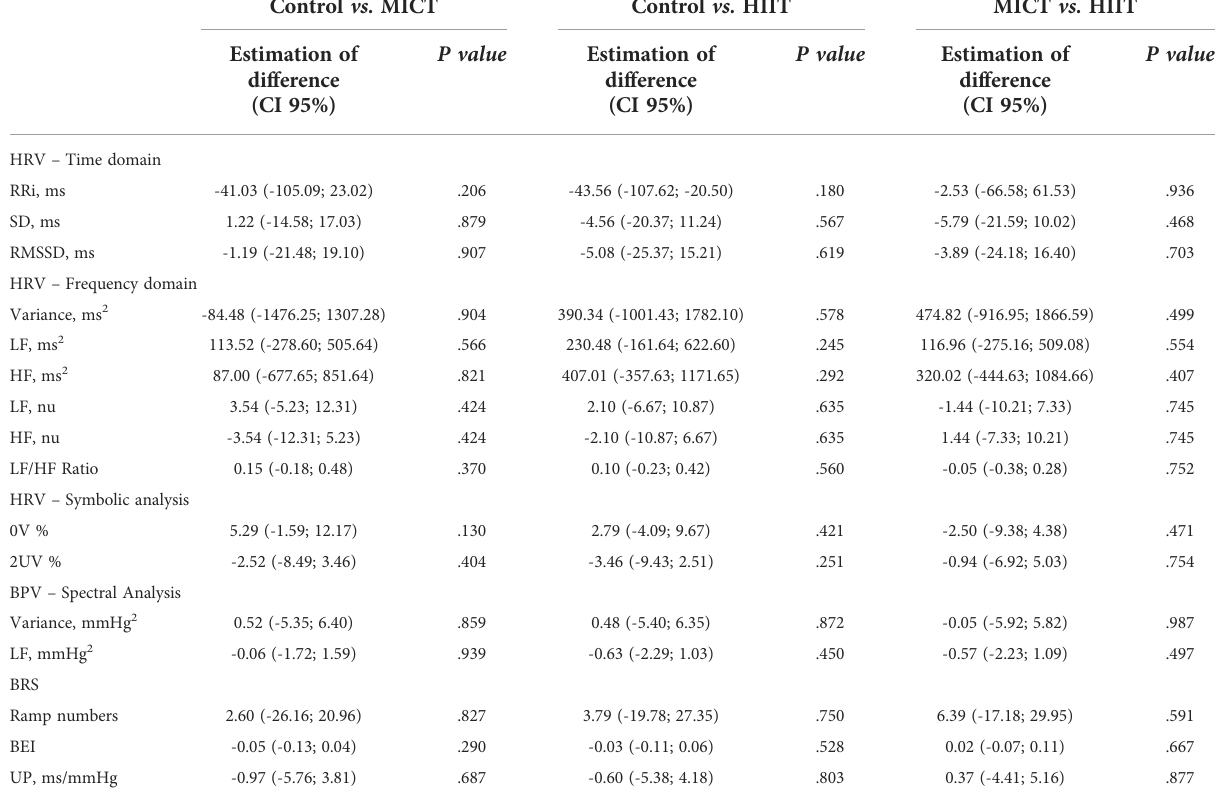
TABLE 6 Intergroup comparison of autonomic parameters obtained after the 16-wk of physical training. Control vs. MICT Control vs. HIIT MICT vs.